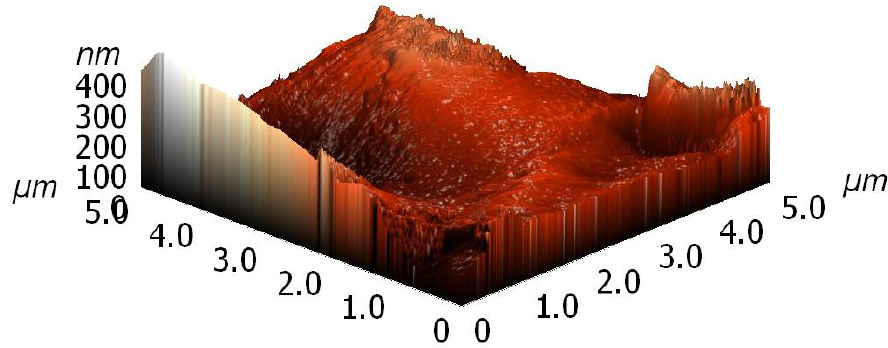
Figure 9. Three-dimensional atomic force microscopy (AFM) image of a 5 μm × 5 μm area of an untreated granule.